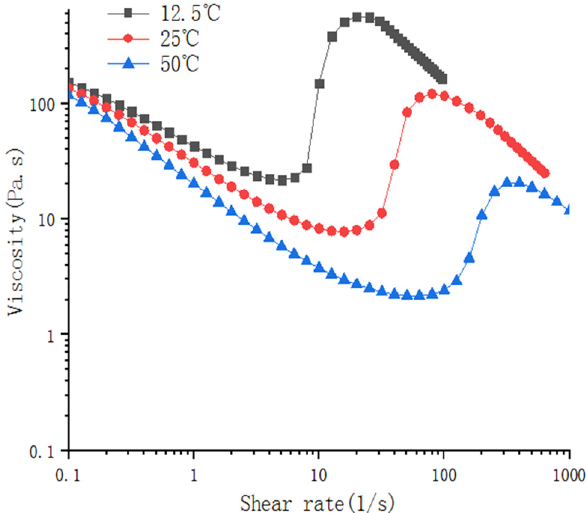
Figure 13: The apparent viscosity of the 0.15% MWCNTs – PVP/ SiO 2 – STF system changes with